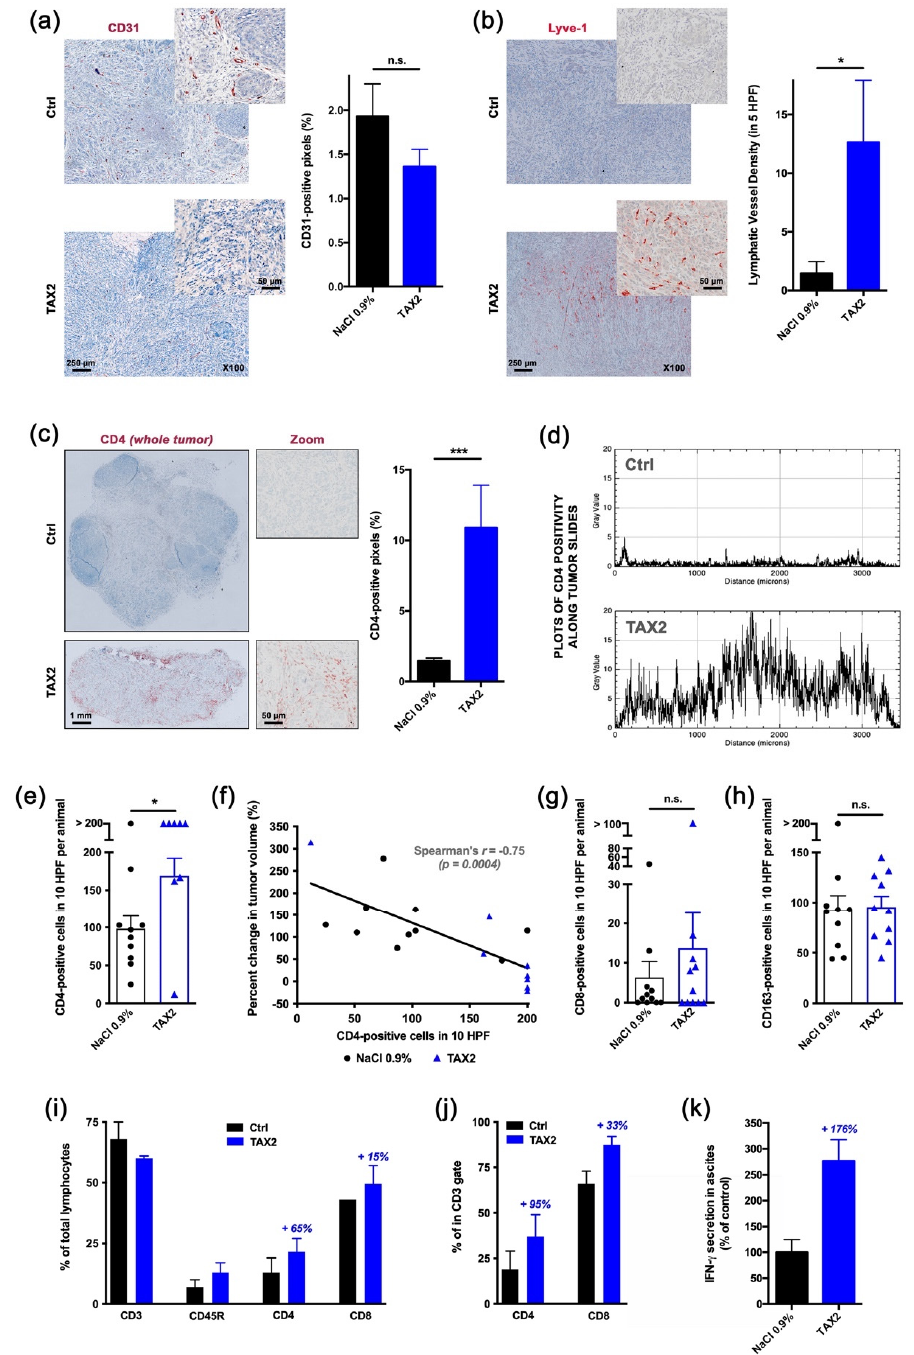
Figure 4. Proof-of-mechanism study for TAX2 use as an anti-tumor immunomodulatory drug. The effects of TAX2 peptide treatment on the activation of an anti-tumor immune response were investigated in two syngeneic models of epithelial ovarian carcinoma. We inoculated 5 × 10 6 ID8 cells either subcutaneously or intraperitoneally to C57BL/6JRj mice in order to mimic primary tumor growth ( a – h ) and metastatic dissemination (peritoneal carcinosis, i – l ), respectively. TAX2 treat- ments (30 mg.kg − 1 BW) vs. vehicle injections (0.9% NaCl) were performed thrice weekly for 4 and 8 weeks for the s.c. and